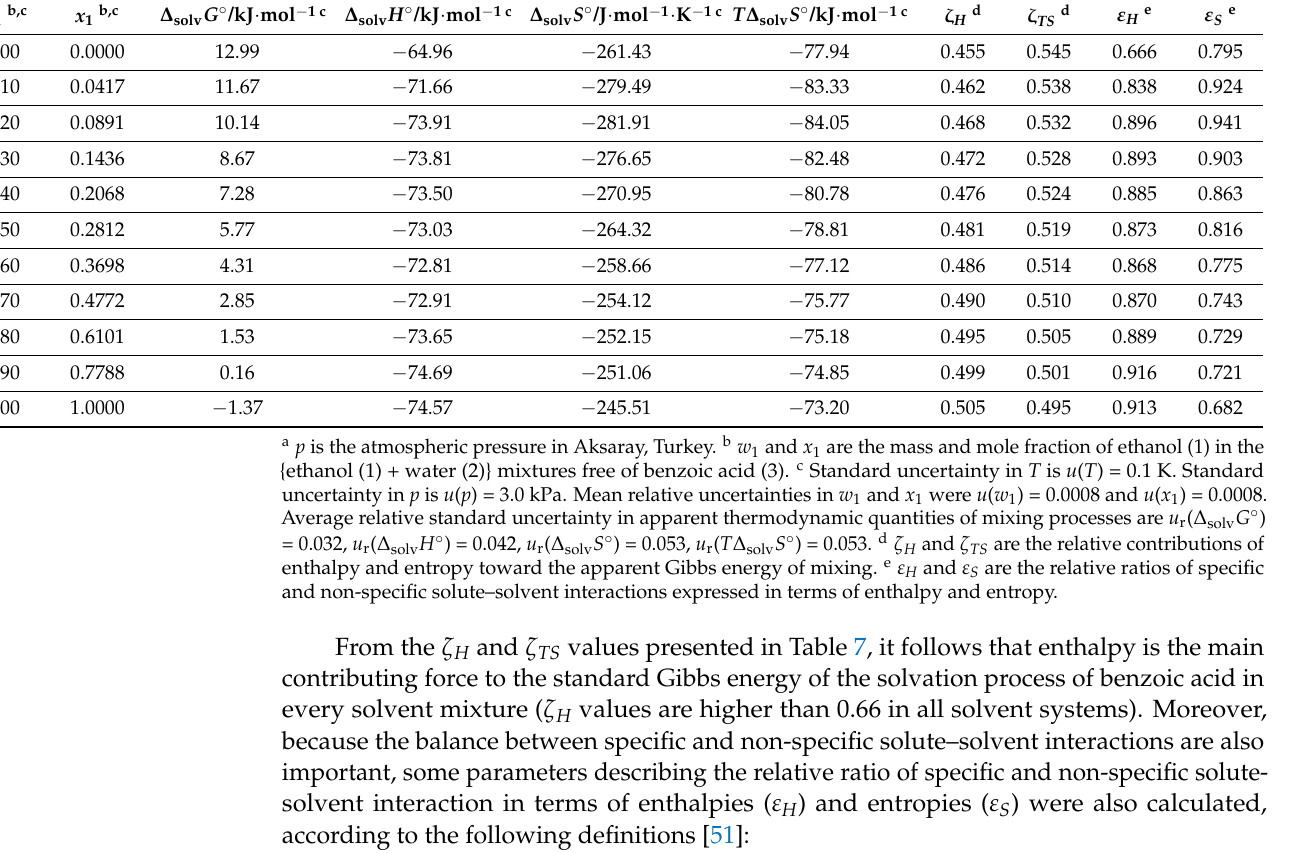
Table 7. Apparent thermodynamic functions relative to solvation processes of benzoic acid (3) in {ethanol (1) + water (2)} mixtures at T = 298.15 K and p = 90 kPa. a,c. w 1 b,c x 1 b,c